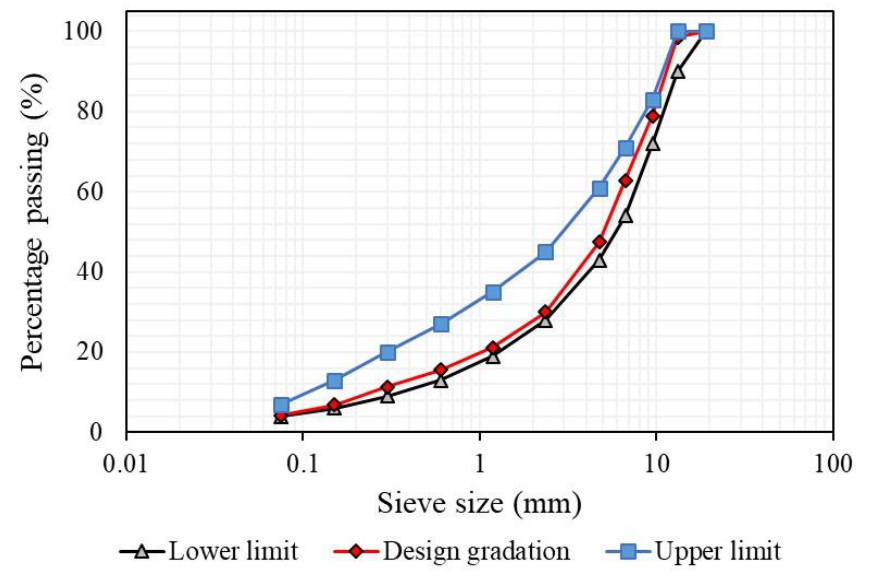
Figure 2. Gradation curve for AC 14.